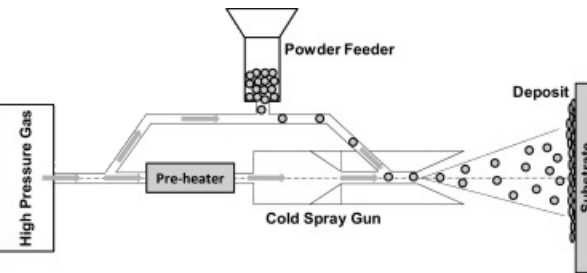
Figure 4. Schematic representation of cold spray process